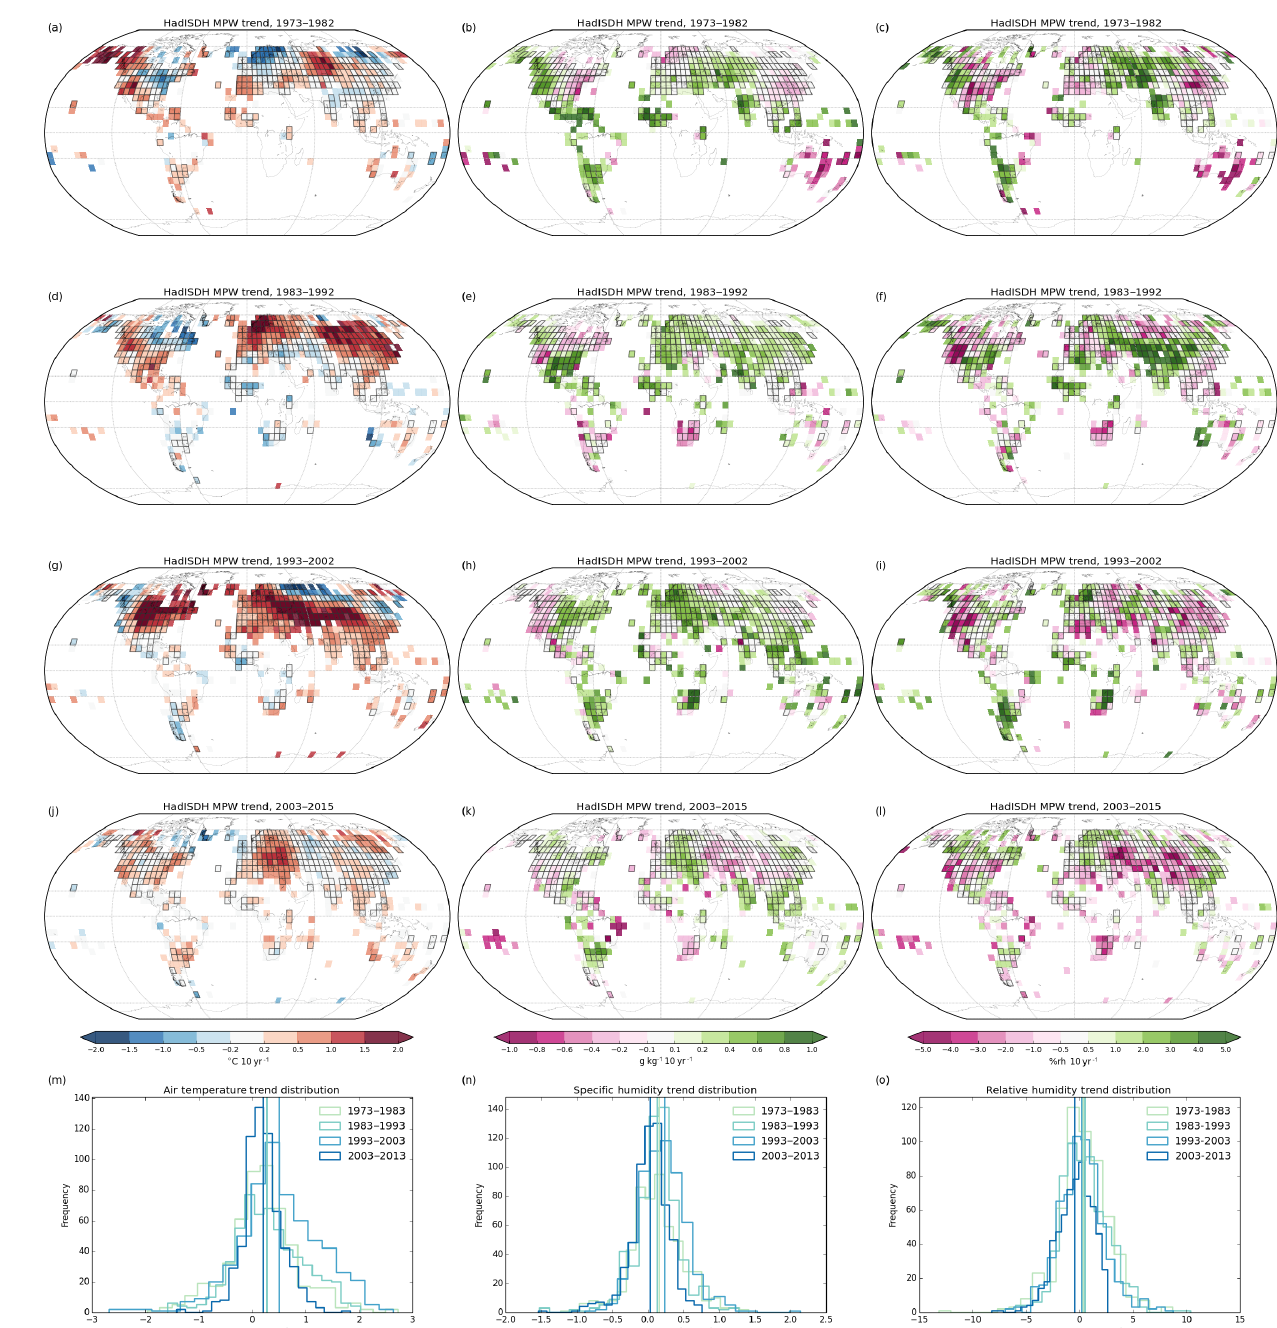
Figure 1. Decadal trends (over 13 years for final interval) as calculated from HadISDH for temperature, specific humidity and relative humidity. Slopes have been calculated using the robust median of pairwise slopes estimator (MPW; Theil, 1950; Sen, 1968; Lanzante, 1996). Grid boxes that contain a median of three or more stations in each month have been highlighted with a thick line. Panels (m–o) show the distribution of the trends from each of the four periods. The vertical lines show the latitude-weighted mean of the trends in each decade.